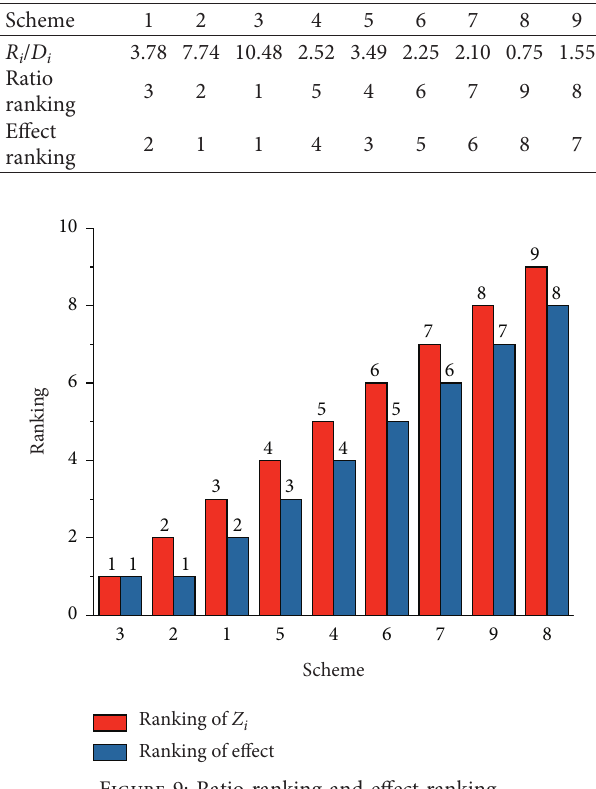
Table 8: Calculation of R